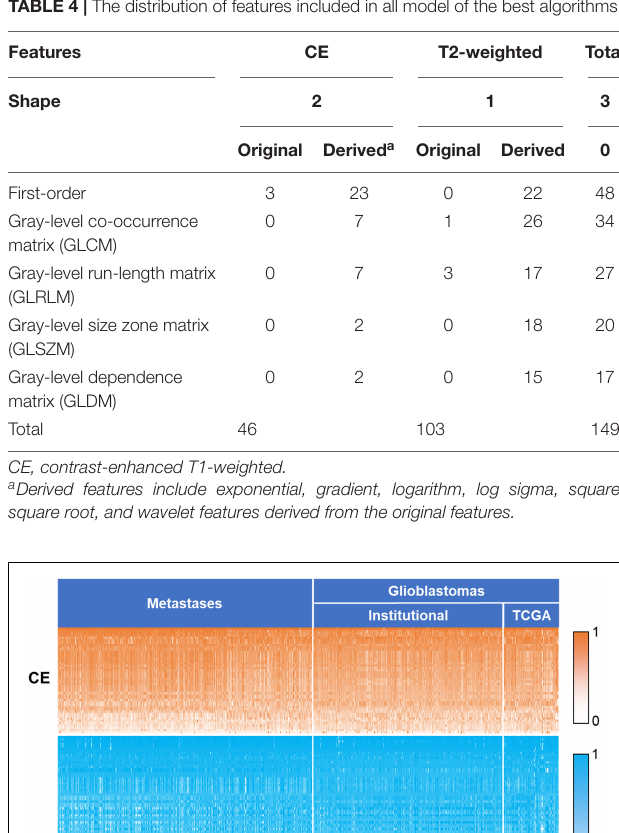
TABLE 4 | The distribution of features included in all model of the best algorithms. Features